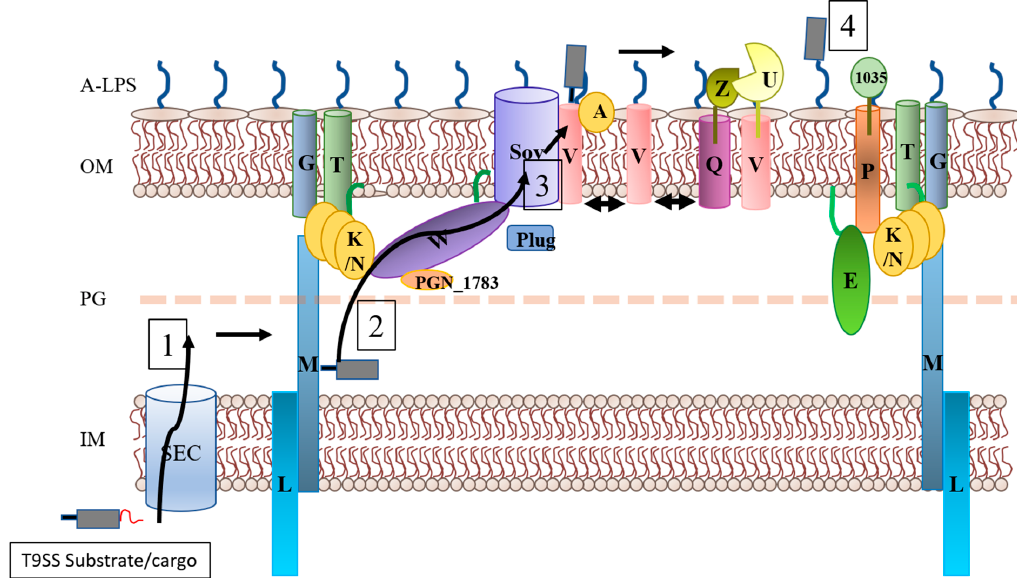
Figure 3. The proposed model of the T9SS. The T9SS substrates (cargo proteins) contain an N-terminal signal (shown as a red line) that allows their passage through the SEC complex. (1) The N-terminal signal is cleaved off and the T9SS substrates are recruited to the T9SS translocation system. (2) The substrates bind to PorM via their C-terminal domain (CTD) signal (black line) and, using this signal, they get passed on to PorN and PorW until they reach the Sov translocon. (3) The substrates are collected by PorV from the Sov channel and PorV shuttles them to the attachment complex consisting of PorU, PorV, PorQ and PorZ, whereby a sortase-like reaction occurs in which the CTD signal is swapped with A-LPS. (4) The substrates are anchored covalently to A-LPS on the cell surface and the CTD signal is released into the culture fluid.